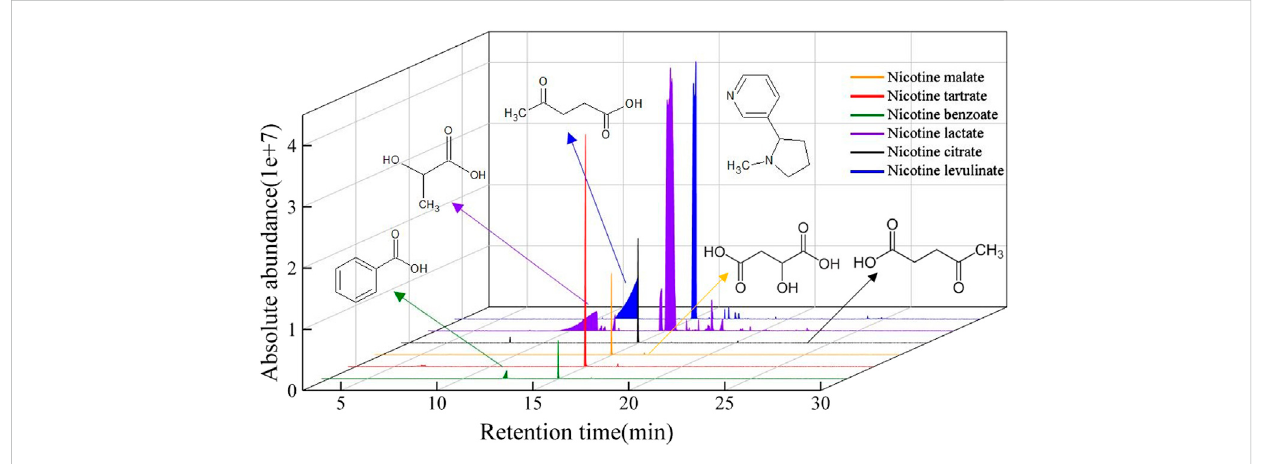
FIGURE 1 Characteristic chromatographic peaks of six nicotine